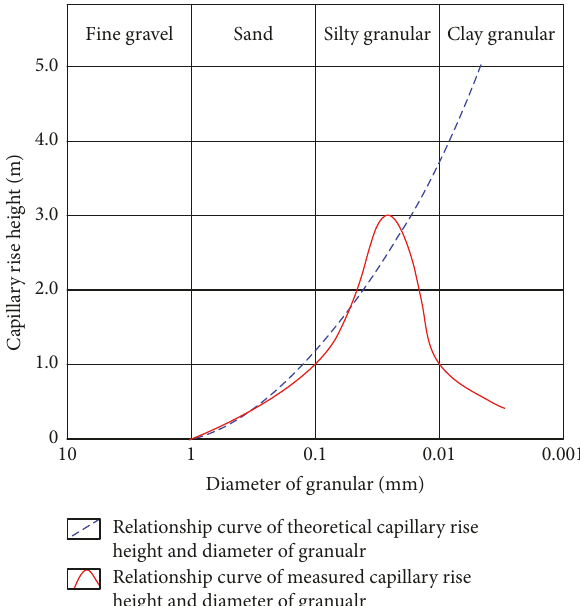
Figure 3: Relationship between capillary rise height and grain size.